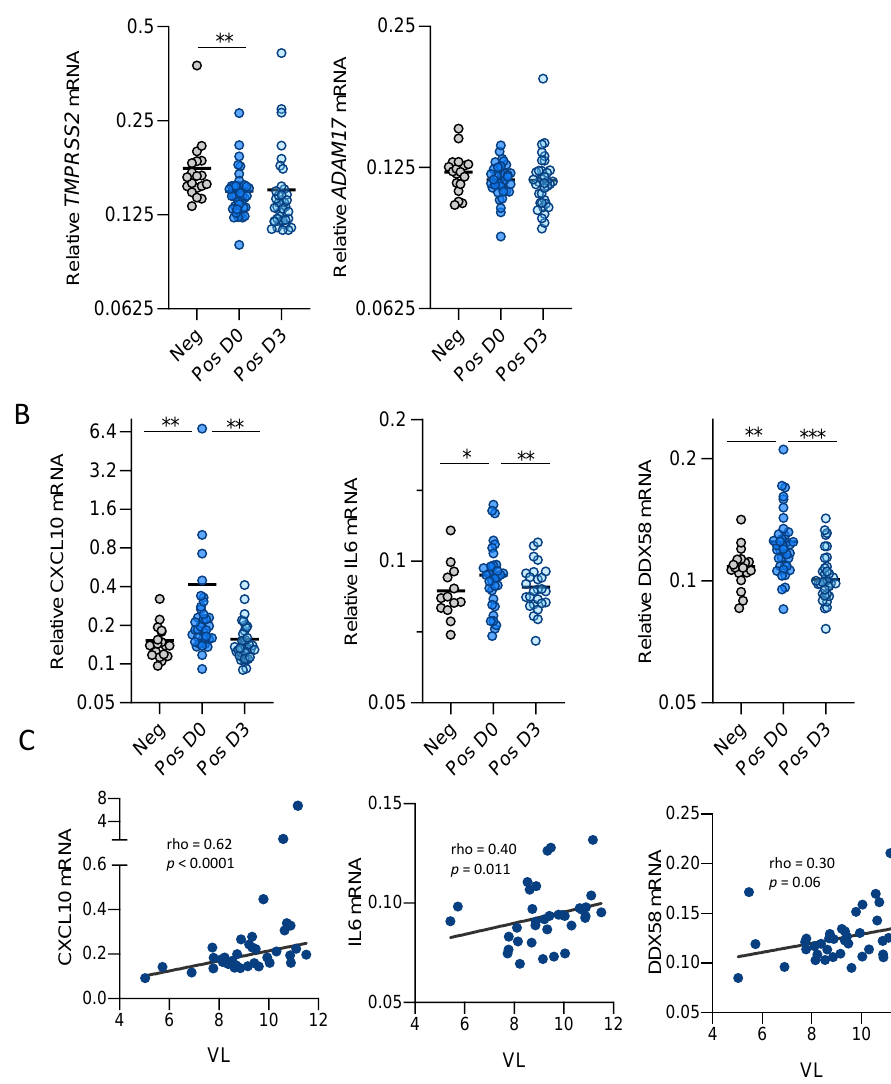
Figure 2. Gene expression modulation by SARS-CoV-2 in longitudinal samples of positive subjects. ( A ) Relative expression of TMPRSS2 (left) and ADAM17 (right) proteases in negative or positive SARS- CoV-2 longitudinal samples. ( B ) Relative expression of different ISGs. Relative mRNA expression was measured by quantitative PCR and normalized to GAPDH. Data represent 1/DCt individual values. ( C ) Positive correlations of DDX58, CXCL10 and IL6 gene expression with viral load. Data are shown as mean ± SEM and analyzed by Mann–Whitney U test, * p < 0.05, ** p < 0.01, *** p < 0.001. Linear correlation (Spearman) r and p -values are